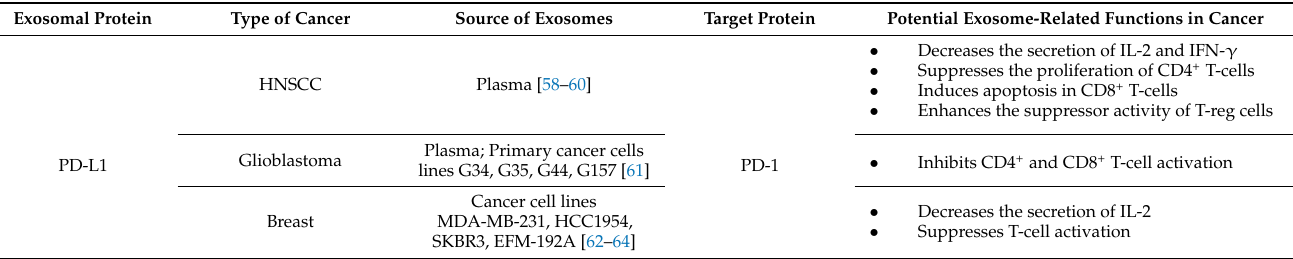
Table 1. Characteristics of the immunomodulating proteins from tumor-derived exosomes presented in this review. PD-L1: programmed death-ligand 1; HNSCC: head and neck squamous cell carcinoma; IL: interleukin; IFN: interferon; TNF: tumor necrosis factor; EMT: epithelio-mesenchymal transition; MDSC: myeloid derived suppressor cells, NSCLC: non-small cell lung cancer; CRC: colorectal cancer; NPC: nasopharyngeal carcinoma. Exosomal